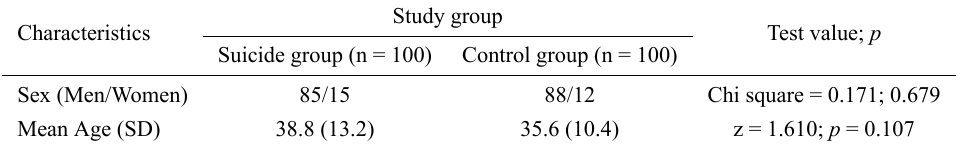
Table 2. Comparison of the demographic characteristics of the study group.